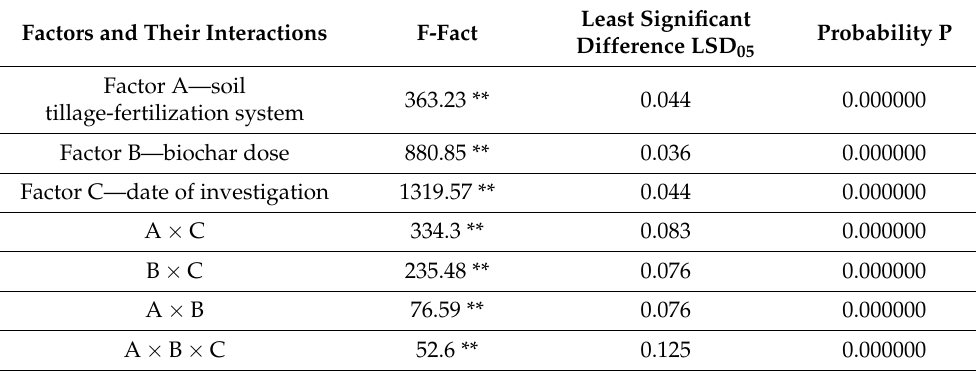
Table 2. Variance analysis of soil organic matter content, n = 3.